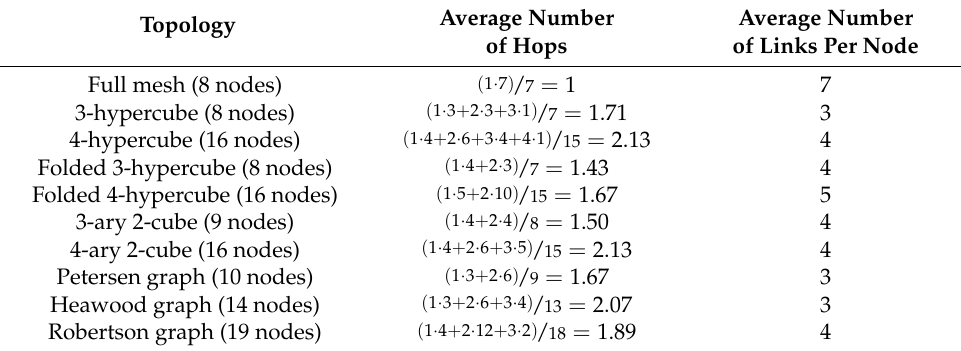
Table 7. Average number of hops and average number of links per node. Topology Average Number